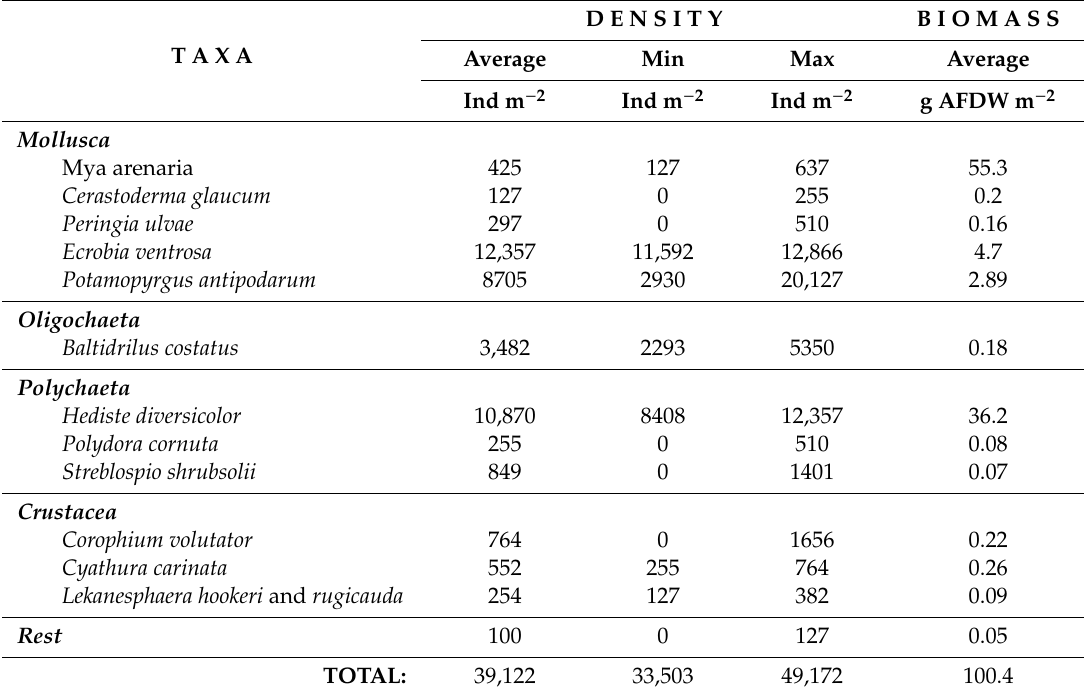
Table 1. Density and ash free dry weight (AFDW) of the most abundant species (0.5 mm mesh size) from 3 replicates taken parallel to the sediment sampling for incubation experiments at Breitling Bay (54 ◦ 10.6 (cid:48) N; 12 ◦ 08.2 (cid:48) E).